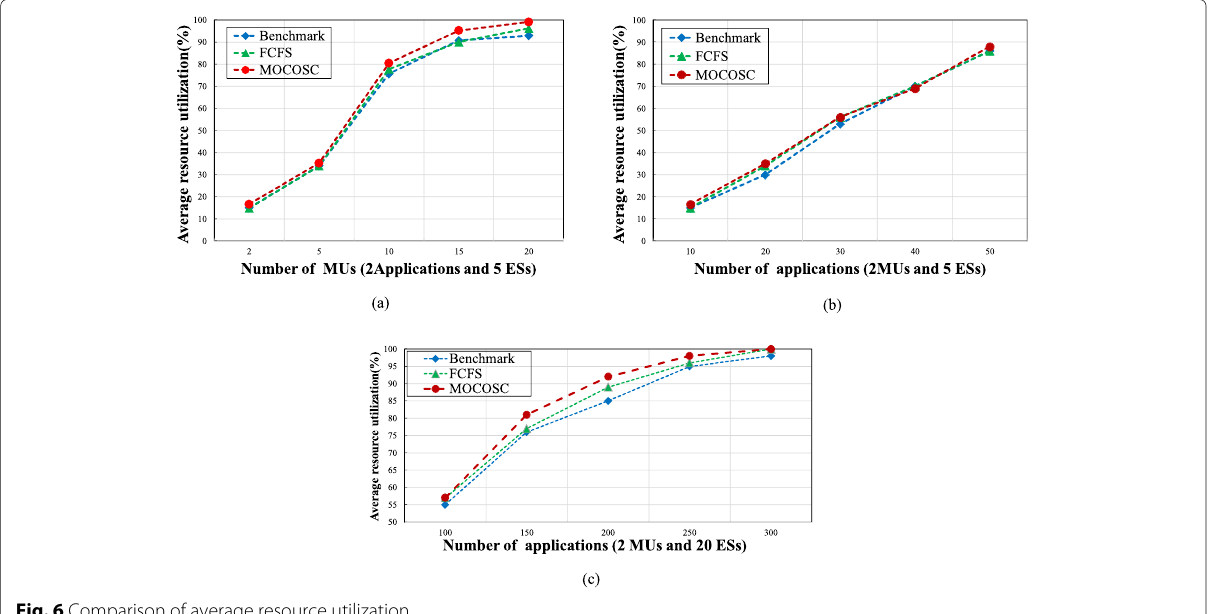
Fig. 6 Comparison of average resource